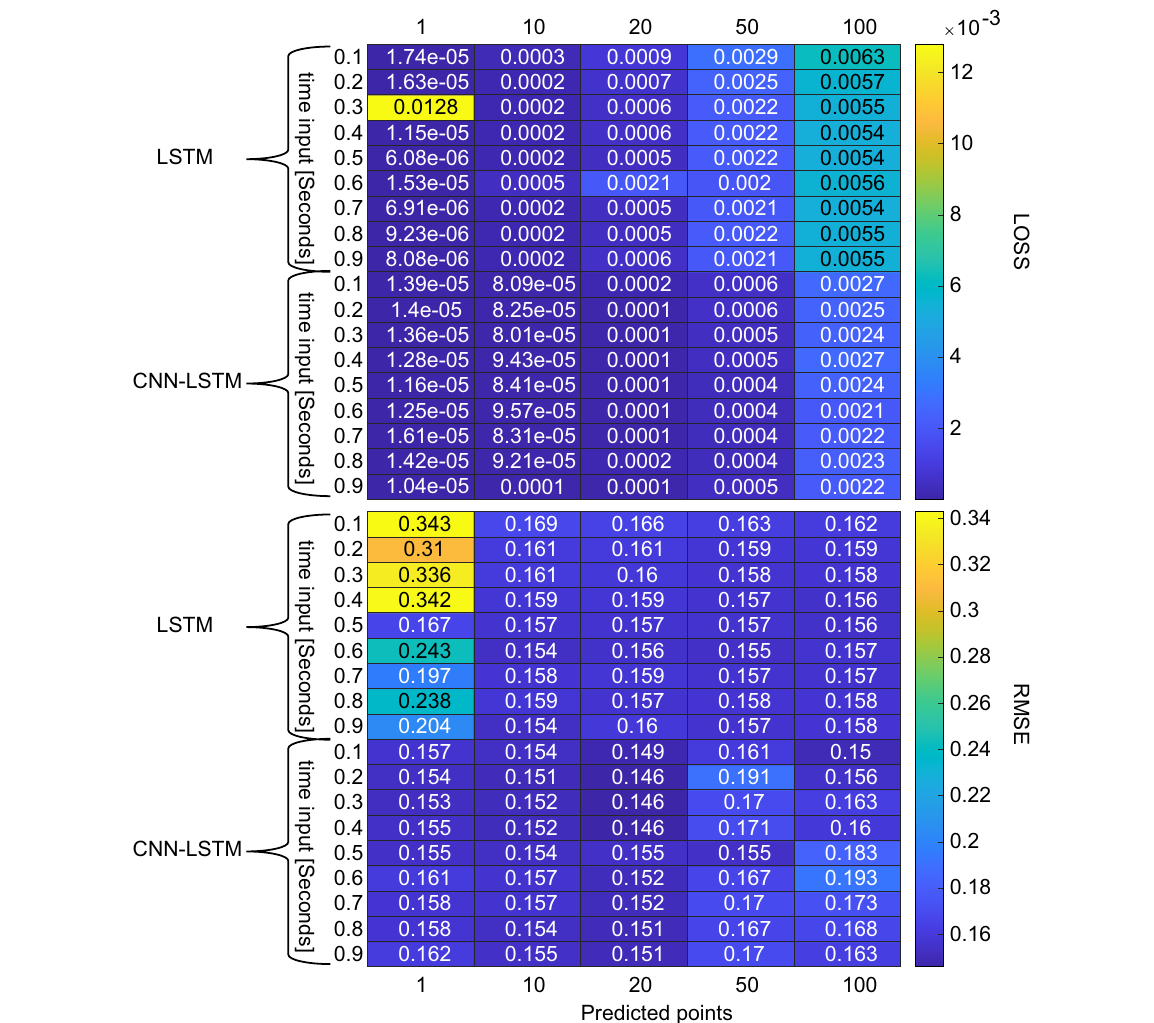
Fig. 5 Validation loss (top) and test set RMSE (bottom) of each predicted points (column) vs time input (row) of the LSTM and CNN-LSTM models trained with data set 1